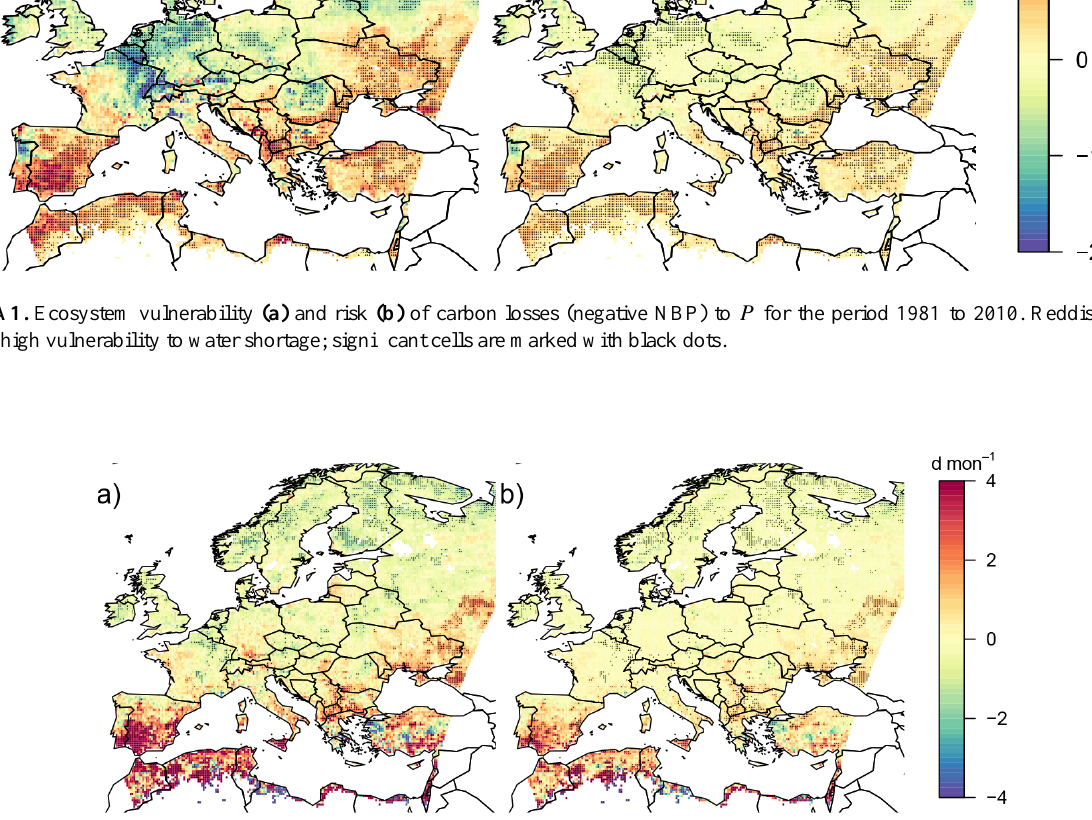
Figure A2. Ecosystem vulnerability (a) and risk (b) of carbon losses (negative NBP) to C for the period 1981 to 2010. Reddish colours indicate high vulnerability to drought periods; significant cells are marked with black dots.